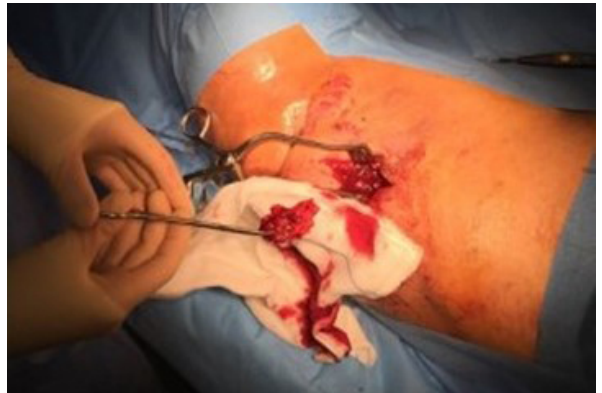
Figure 4. At operation, the infected HO was found deep to the sub- cutaneous fat, on the surface of the muscle. It separated easily from the tissues and was removed.